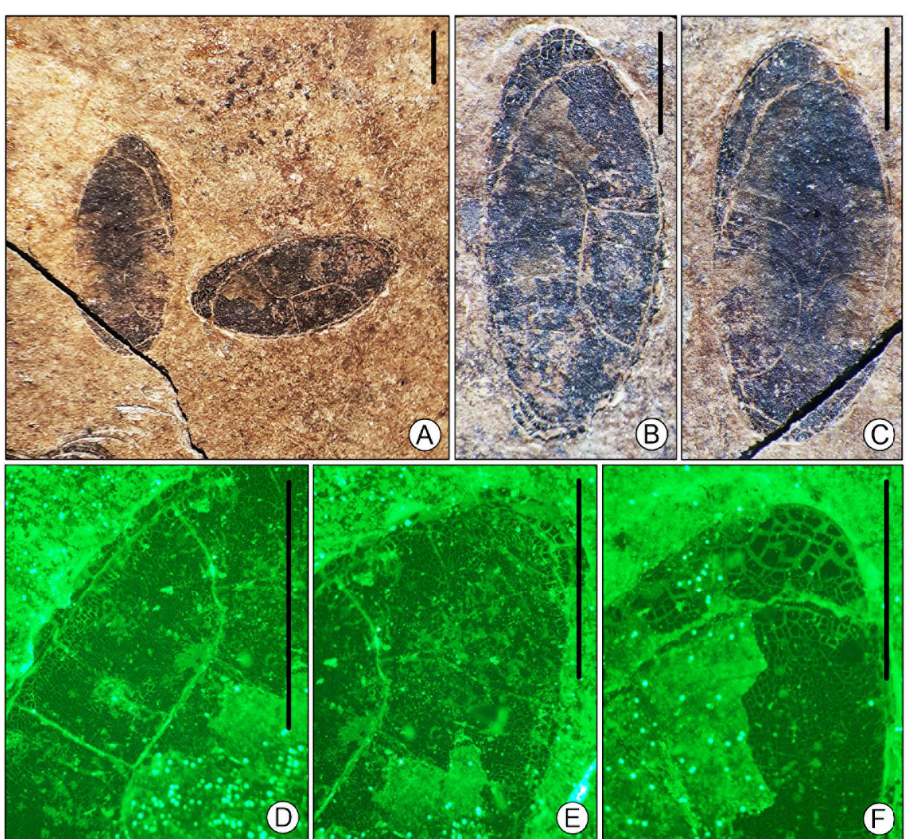
Figure 5. Close-up view of specimen SKBUH/PPL/JH/I3. ( A – C ) Stereo-zoom microscopic images of dipteran pupal cases. ( D – F ) Fluorescence microscopy images of the same adpressions. Scale bar = 1 mm.